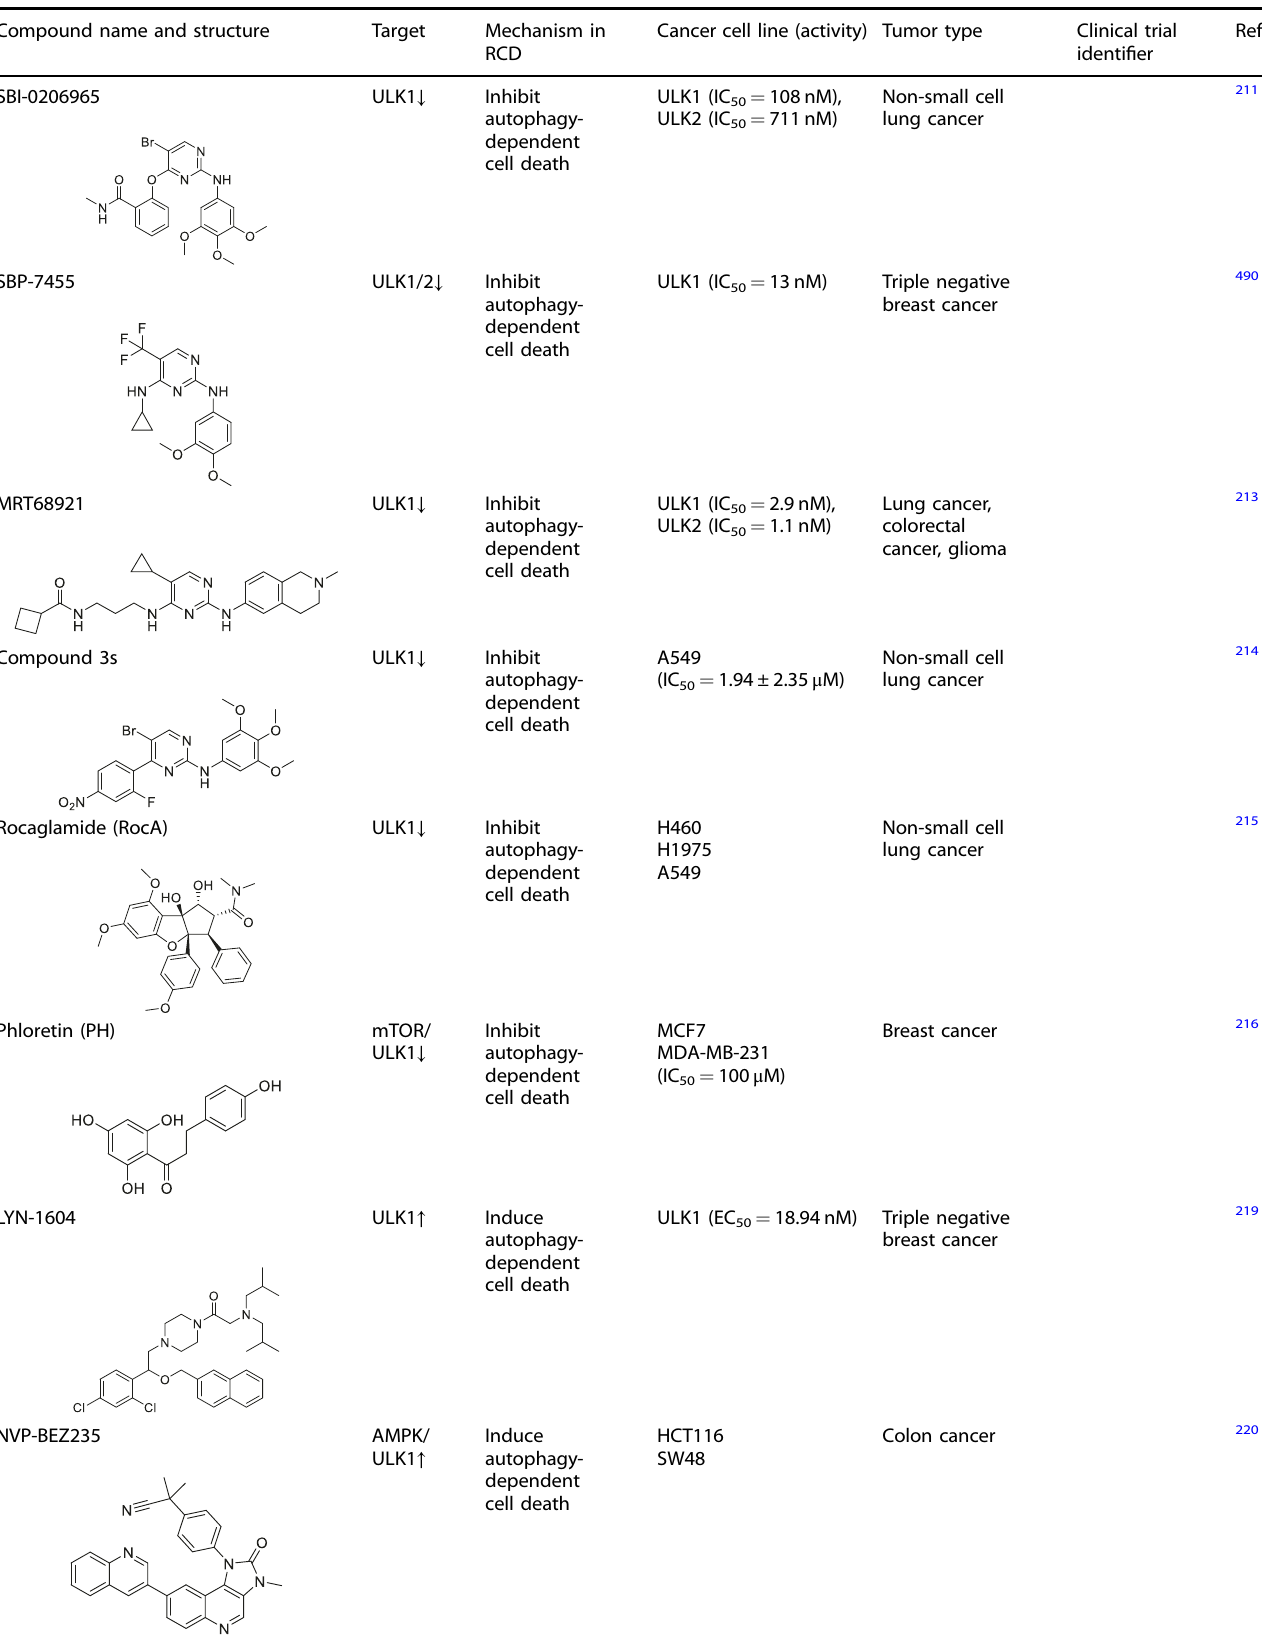
Table 7. Compounds targeting ULK1 and PI3KC1/Akt/mTORC1 in